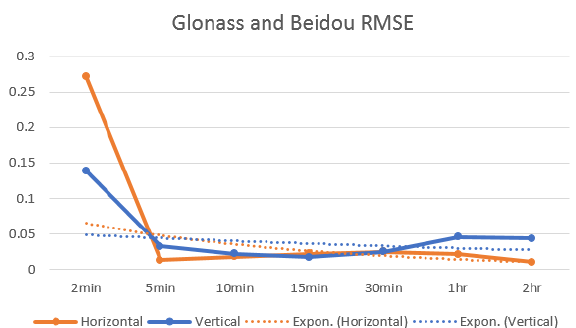
Figure 16. RMSE of horizontal and vertical observations using Glonass and Beidou satellites. Y-axis in